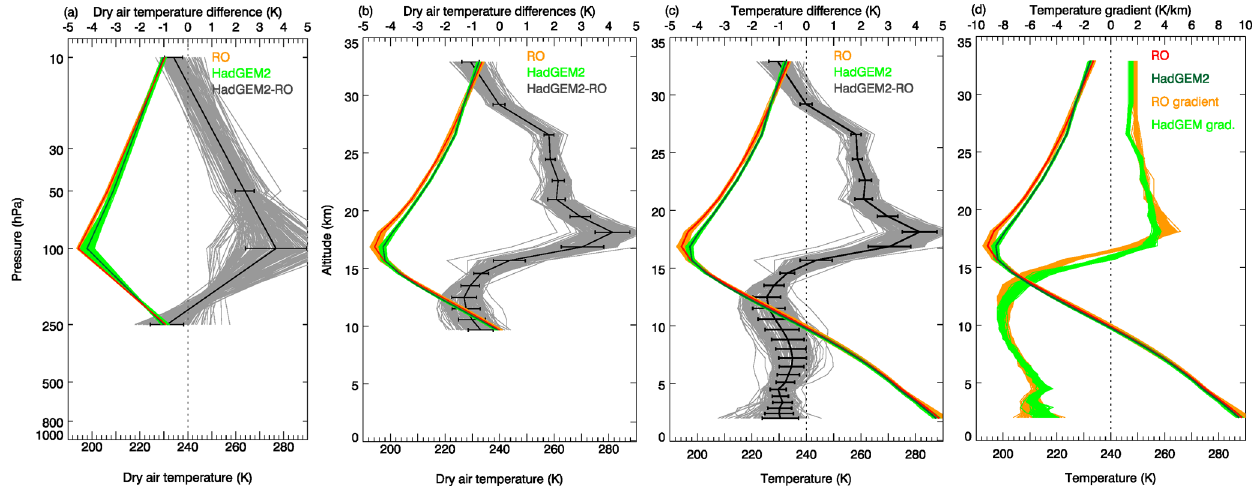
Figure 4. Comparison of HadGEM2-A model data to RO observations for all classes ( ω 500 and T 2m ) in the tropics in terms of collocated temperature profiles and temperature difference profiles of HadGEM2-A minus RO (lower axes depict absolute values, upper axes differences to RO). Shown are dry temperature (see Sect. 2.1) at coarse vertical resolution for four pressure levels (a) , dry temperature at high vertical resolution for altitude levels (b) , and physical temperature at high vertical resolution (c) and corresponding temperature gradients (d) .